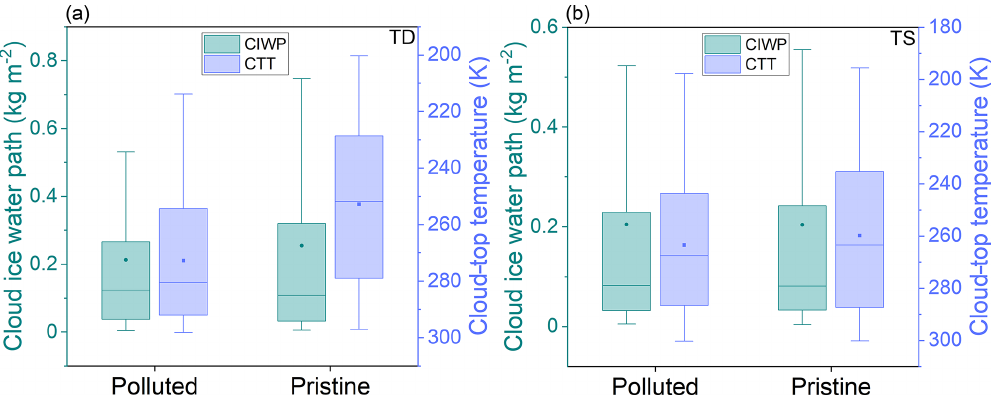
Figure 11. Box plots of CIWP and CTT under polluted and pristine conditions by different TC intensities. (a) TD and (b) TS. The dots and squares represent the average values of CIWP and CTT, respectively. The horizontal lines inside the boxes are the medians, and the bottom and top sides of the boxes represent the first and third quartiles. The whiskers are the minimum (maximum) values within 1.5 interquartile ranges of the lower (upper)